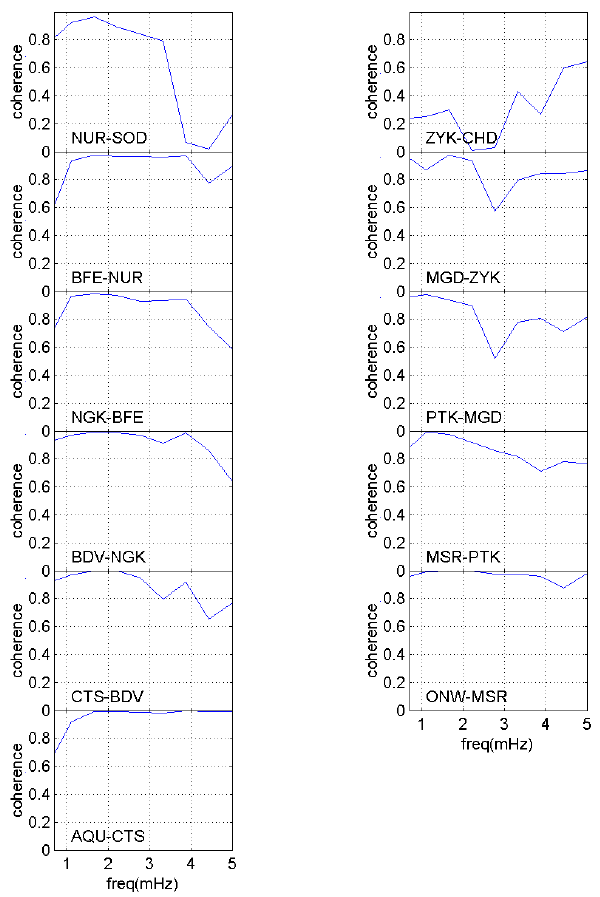
Fig. 5. Coherence between the horizontal geomagnetic field H component in the time interval 07:00–09:00UT at pairs of adjacent stations.